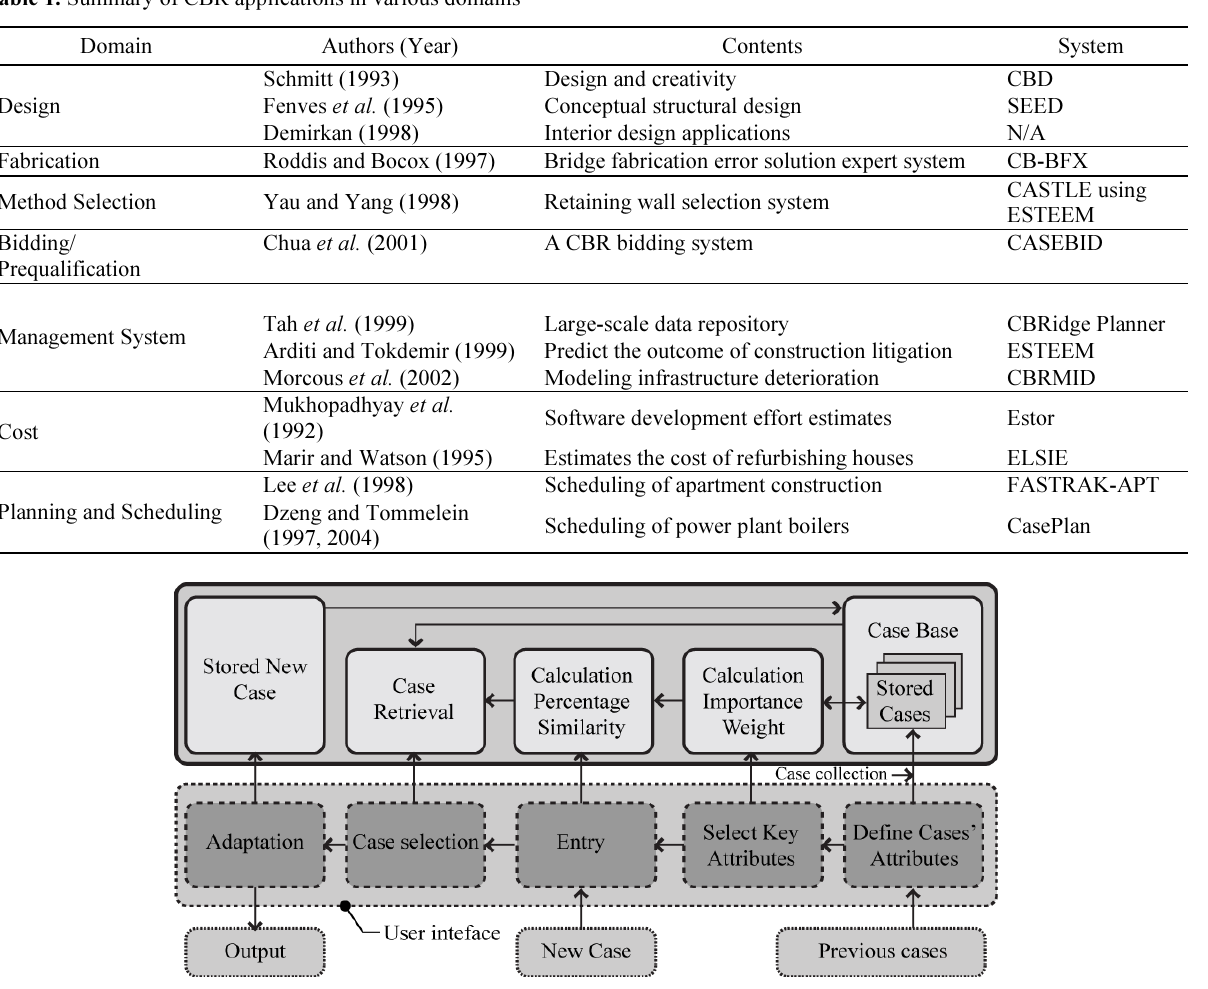
Fig. 1. Case-based reasoning cycle